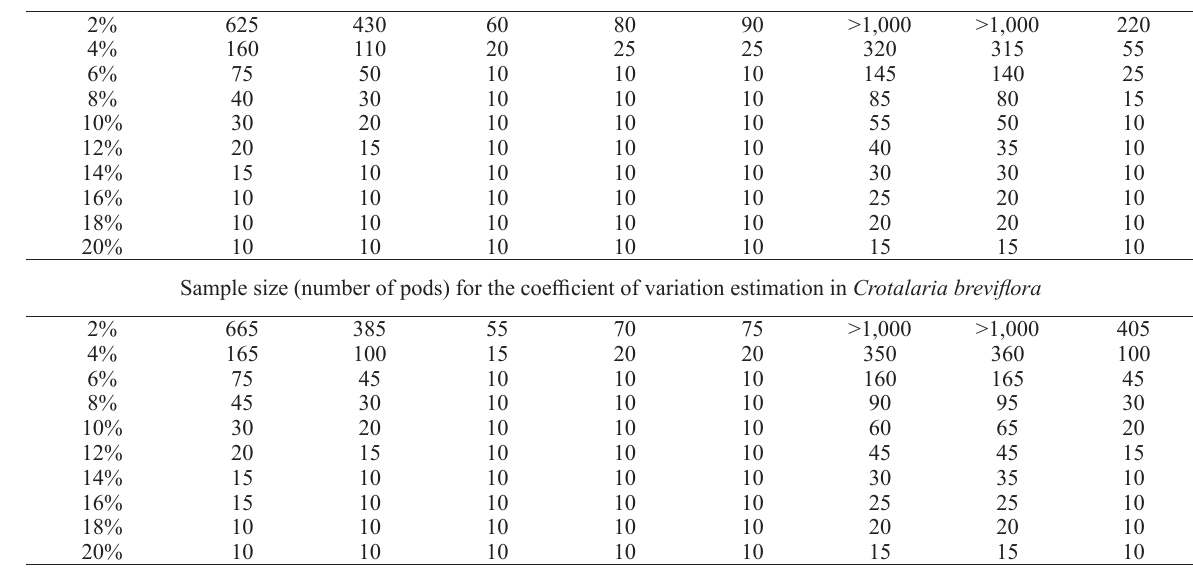
Sample size (number of pods) for the coefficient of variation estimation in Crotalaria